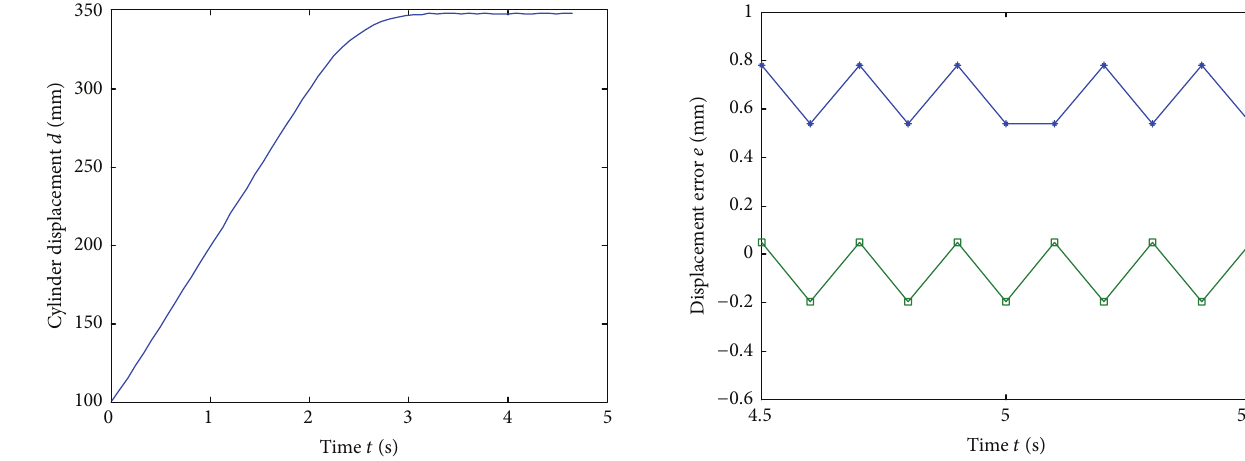
Figure 12: Response of target position 350 mm.